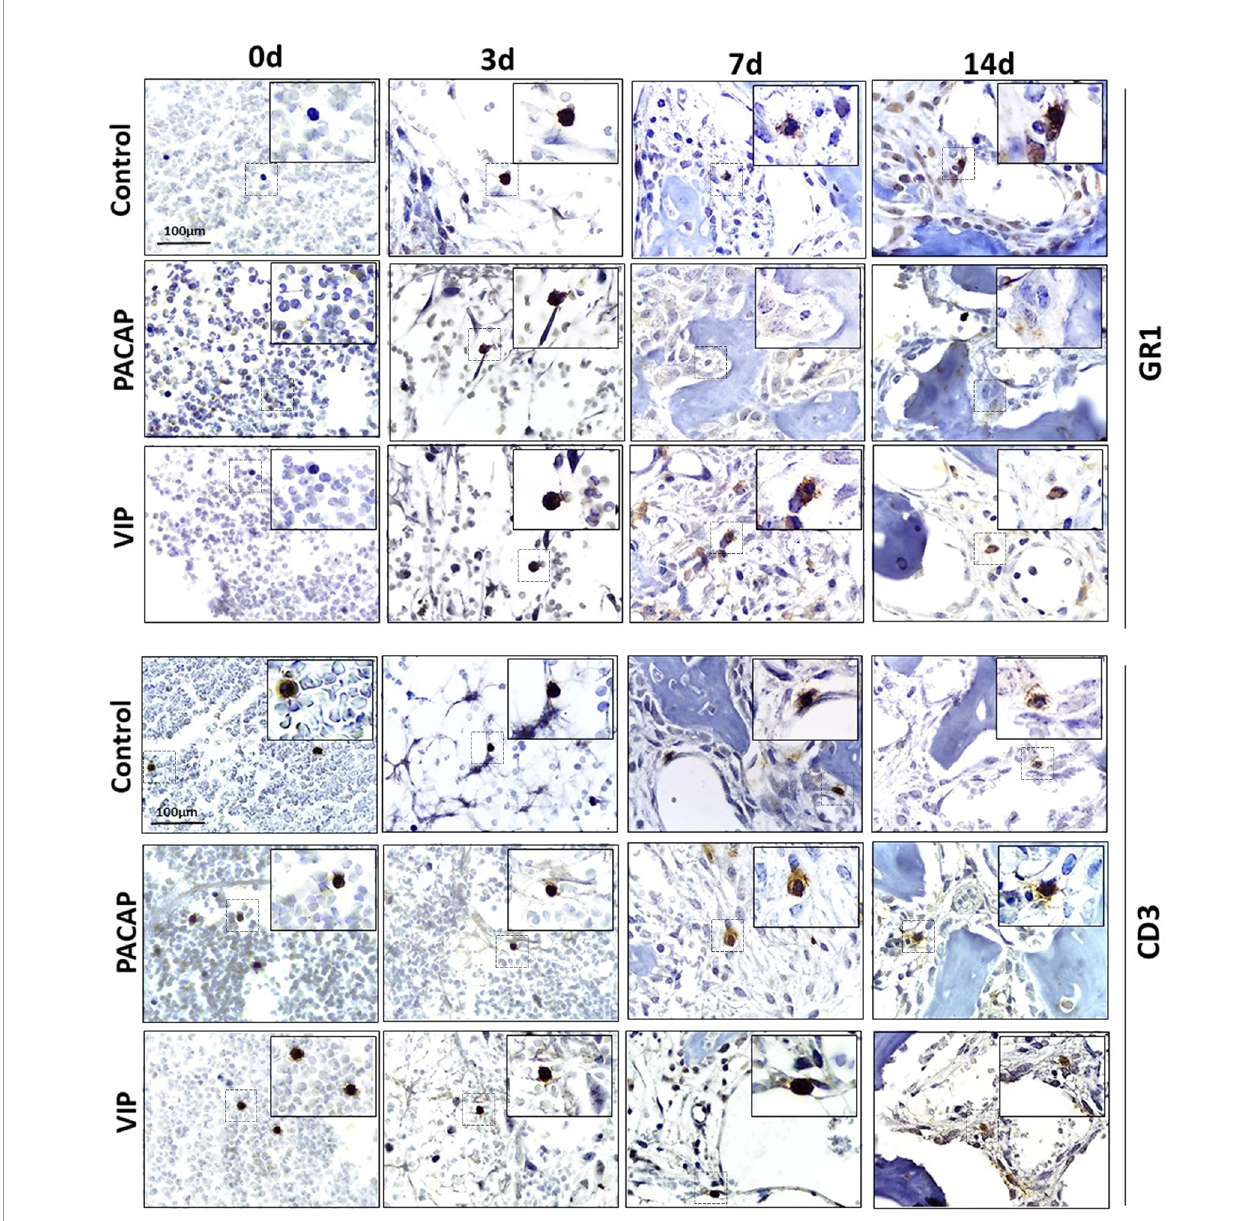
FIGURE 3 | Immunohistochemistry analysis for Ly6g-GR1 + and CD3 + cells present in the bone repair process in control, VIP and PACAP treated groups. Representative sections from medial thirds of the socket at days 0, 3, 7 and 14 days after tooth extraction. Anti-staining Mayer ’ s hematoxylin; objective of